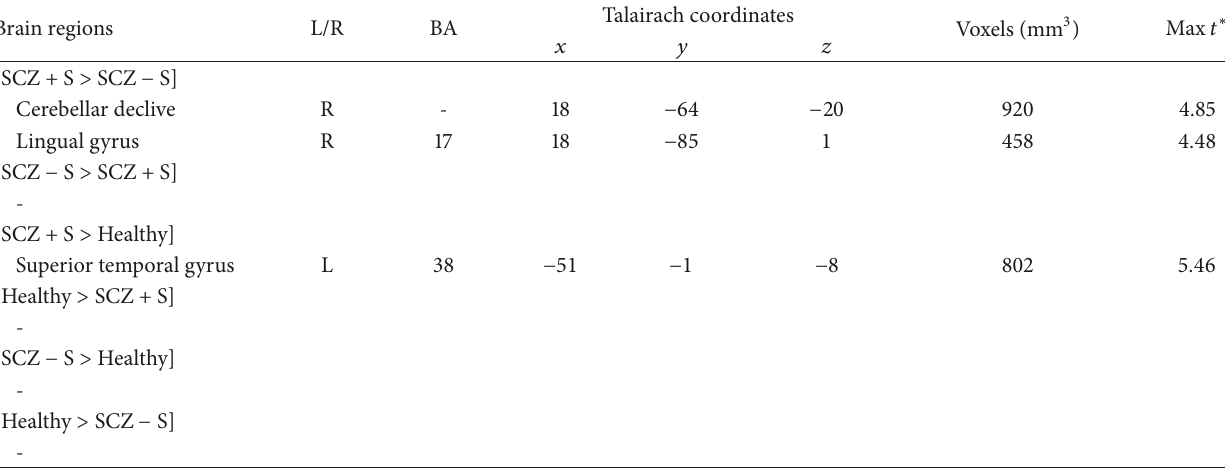
Table 3: Differences in activations between schizophrenia patients (with and without suicidal behavior) and healthy subjects during the parametrically modulated Inflation event.